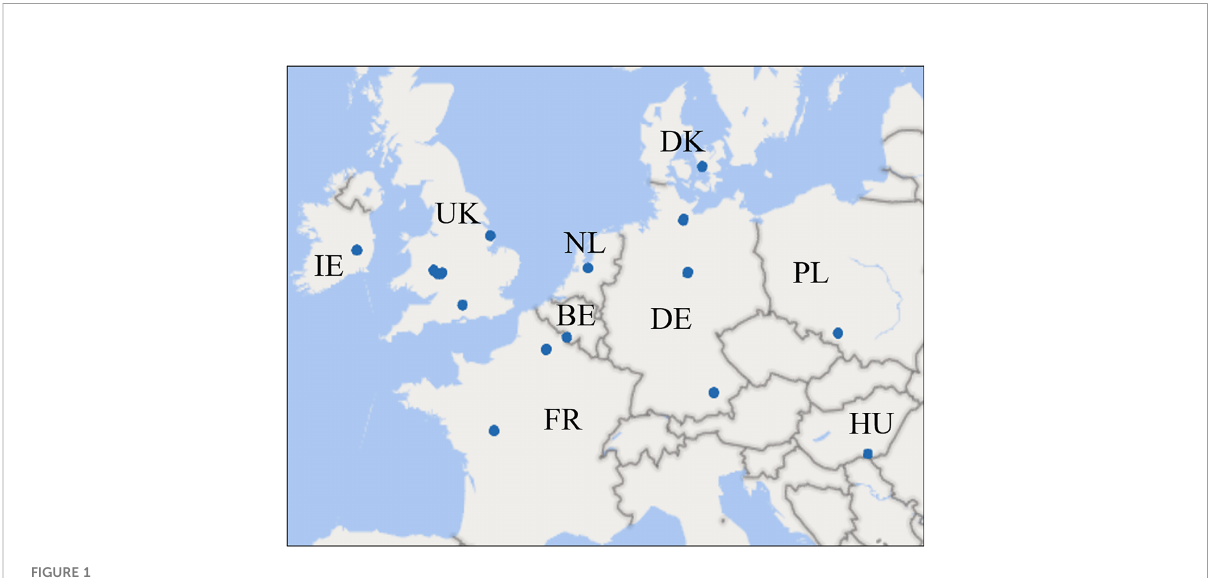
FIGURE 1 Locations of trials carried out from